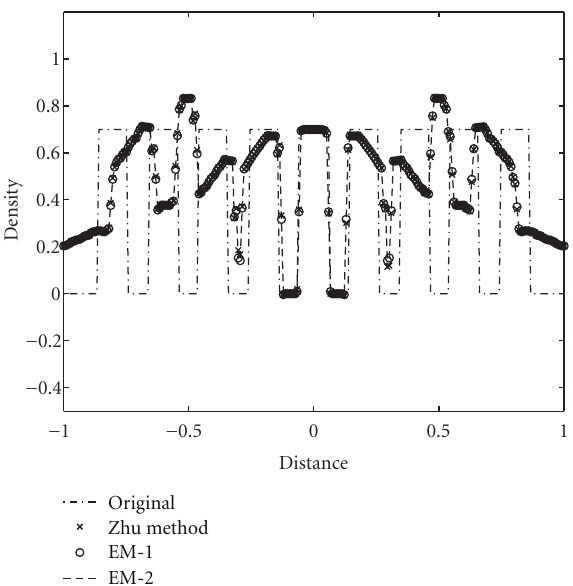
Figure 12: Illustration of axial intensity drop in full-scan recon- structions of Defrise disk phantom, vertical profile of the Defrise disk phantom at z = 0 in Figure 10.